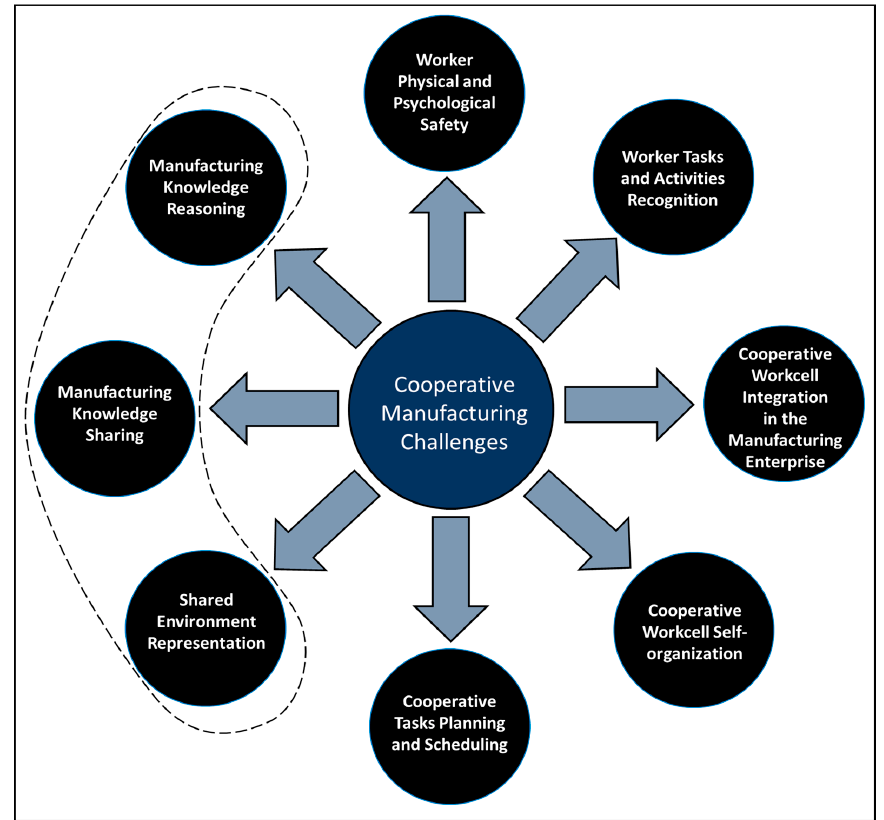
Figure 2. Challenges in Cooperative Manufacturing.